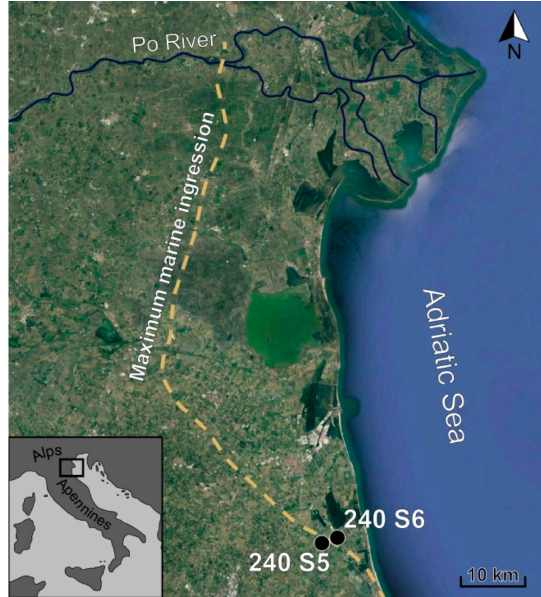
Figure 1. Location of cores 240 S5 and 240 S6. Maximum marine ingression from [51]. Satellite